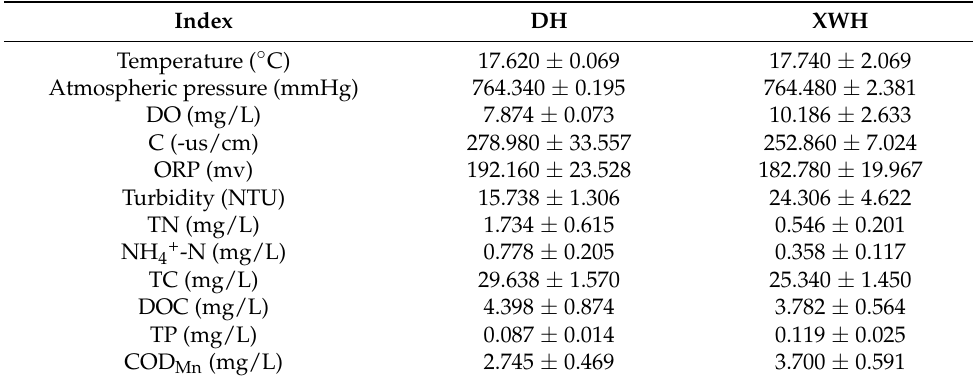
Table 2. Physical and chemical index of water